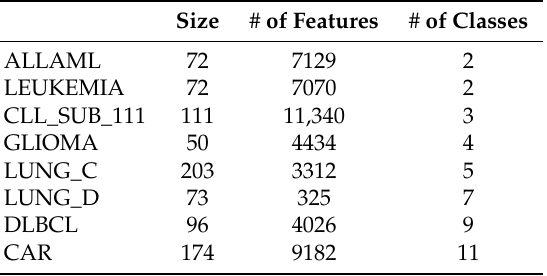
Table 1. Gene expression Datasets